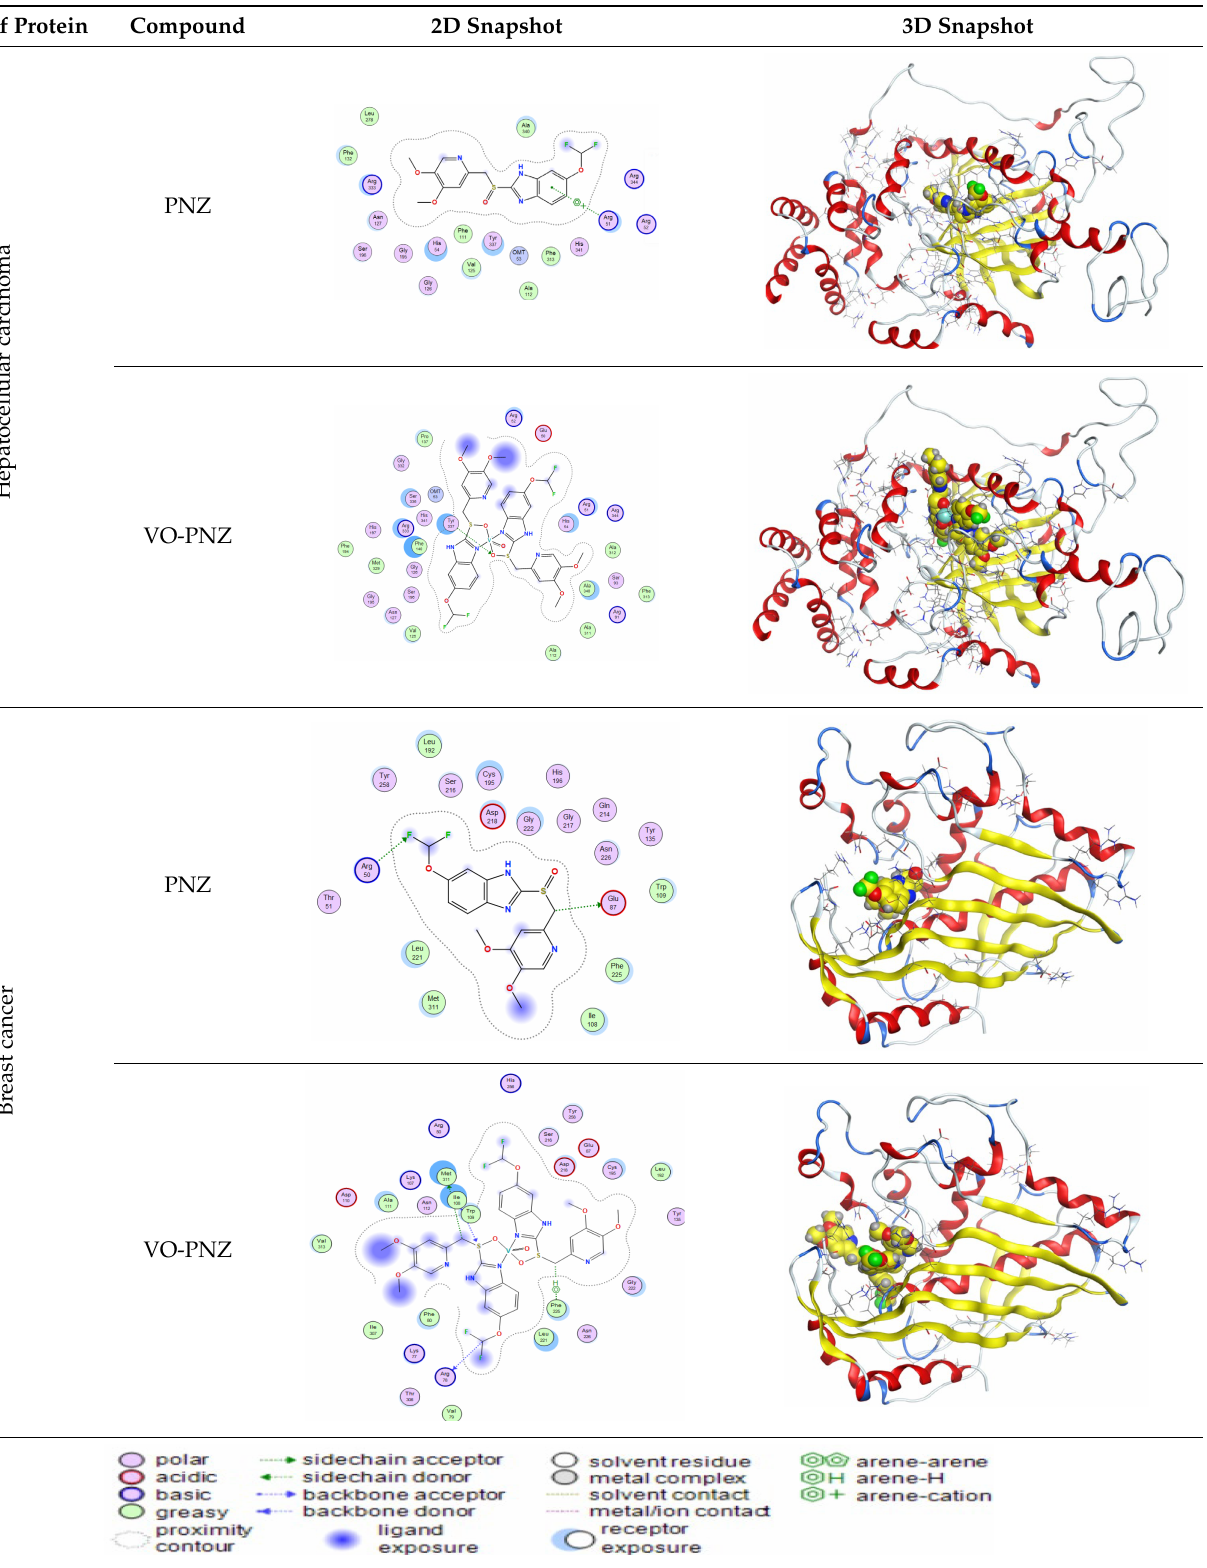
Table 7. 2D and 3D docking interactions of the studied complexes with colon cancer protein “Human Thymidylate Synthase” for hepatocellular carcinoma protein (PDB code = 1JU6) and breast cancer (PDB code = 1HK7)